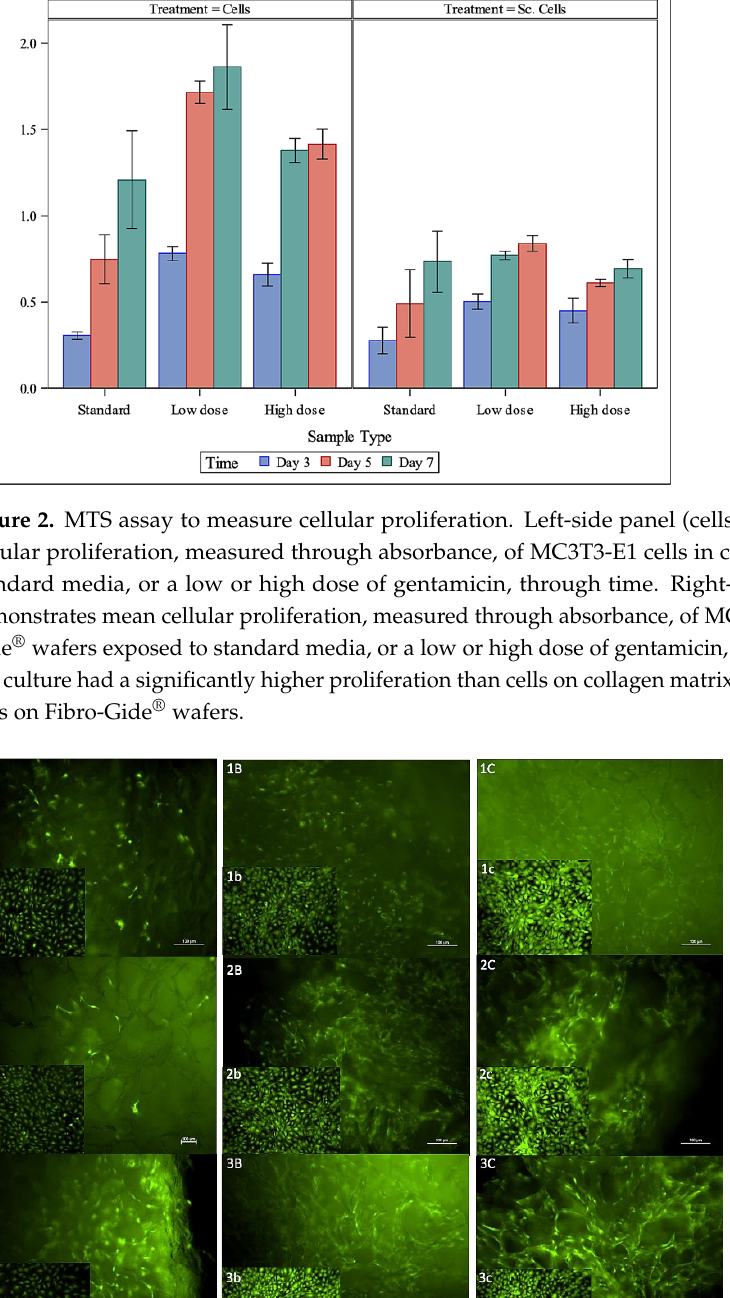
Figure 3. Images of calcein-AM staining of MC3T3-E1 cells on Fibro-Gide ® wafers with inset positive control images of MC3T3-E1 cells in cell culture. ( 1A – 1C ) Cells on matrix on days 3 ( A ), 5 ( B ), 7 ( C ) in standard media. ( 1a – 1c ) Cells in culture on days 3 ( a ), 5 ( b ), 7 ( c ), standard media. ( 2A – 2C ) Cells on matrix on days 3 ( A ), 5 ( B ), 7 ( C ) exposed to low dose gentamicin. ( 2a – 2c ) Cells in culture on days